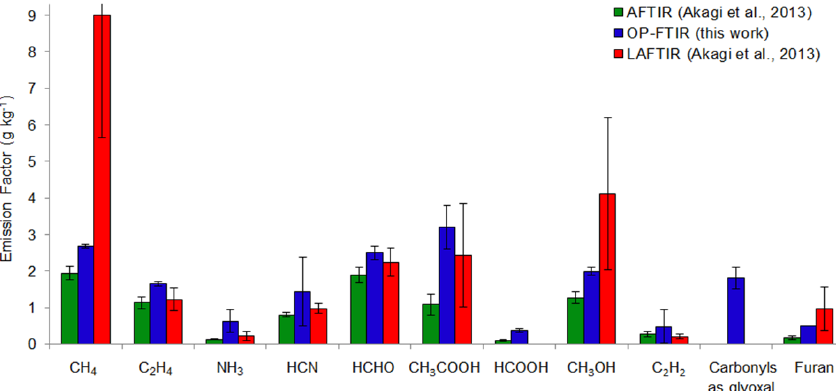
Fig. 5. Side-by-side comparison of study-average emission factors between the AFTIR (green), OP-FTIR (blue), and LAFTIR (red) FTIRs employed during the Fort Jackson campaign. The EFs and error bars represent the average EF and 1- σ standard deviation over all three of the Fort Jackson fires,